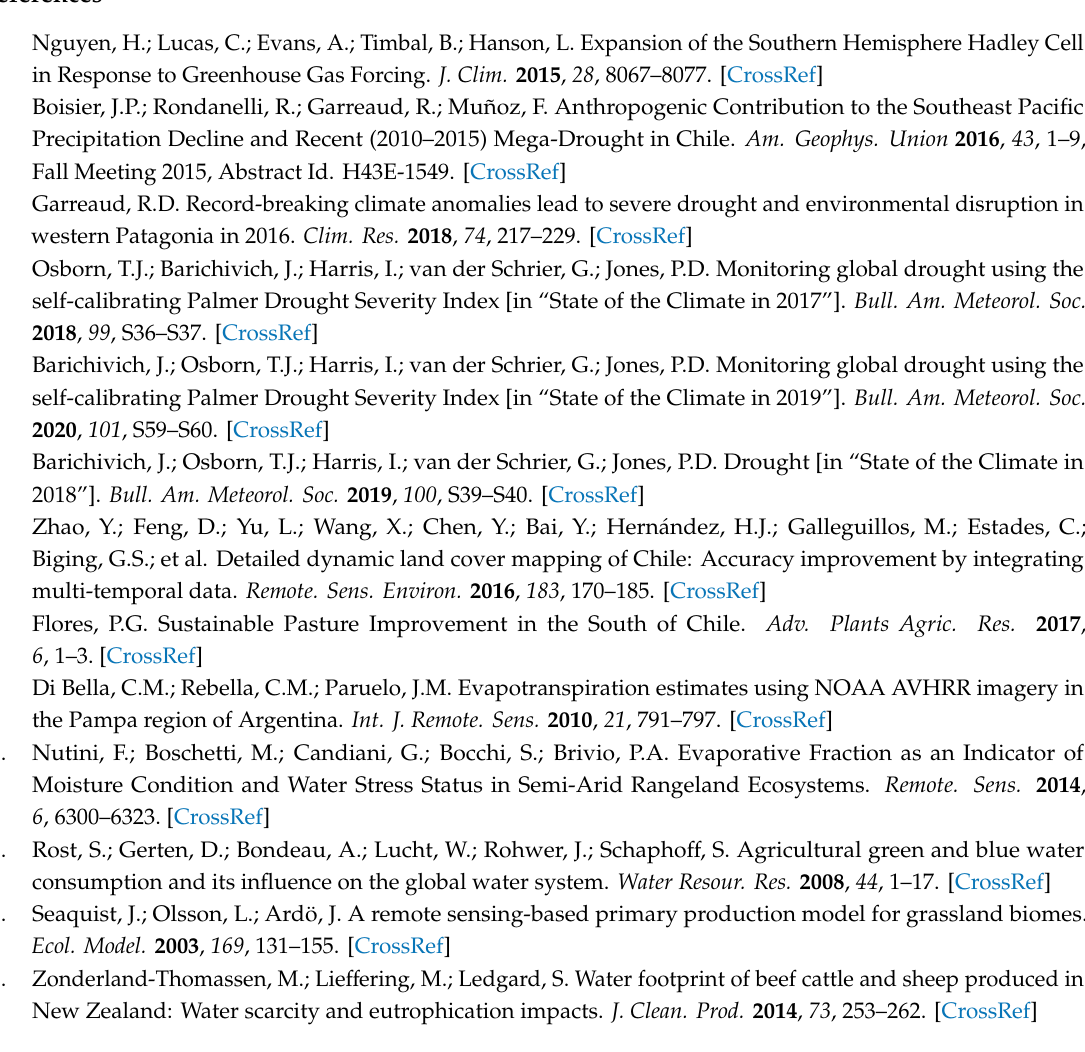
Figure S1. Meteorological data for the study area. (A) is the wind speed [m s − 1 ], (B) air temperature [K], (C) instantaneous global radiation [W m − 2 ] y (D) relative humidity [%]. The meteorological information is on a topography layer of the regi ó n represented in gray. Figure S2. Validation of relative humidity (RH), global radiation (Rx), air temperature (Ta) and wind speed (u). (A). Scatterplot of RH, Rx, Ta and u in Oromo Calibration Site (x-axis) and spatially interpolated variables (y-axis). (B) Evaluation of bias, sigma and RMSE at pixel scale over OCS. Figure S3. Spatial correlation between global models (GLEAM and PML) and SSEBop